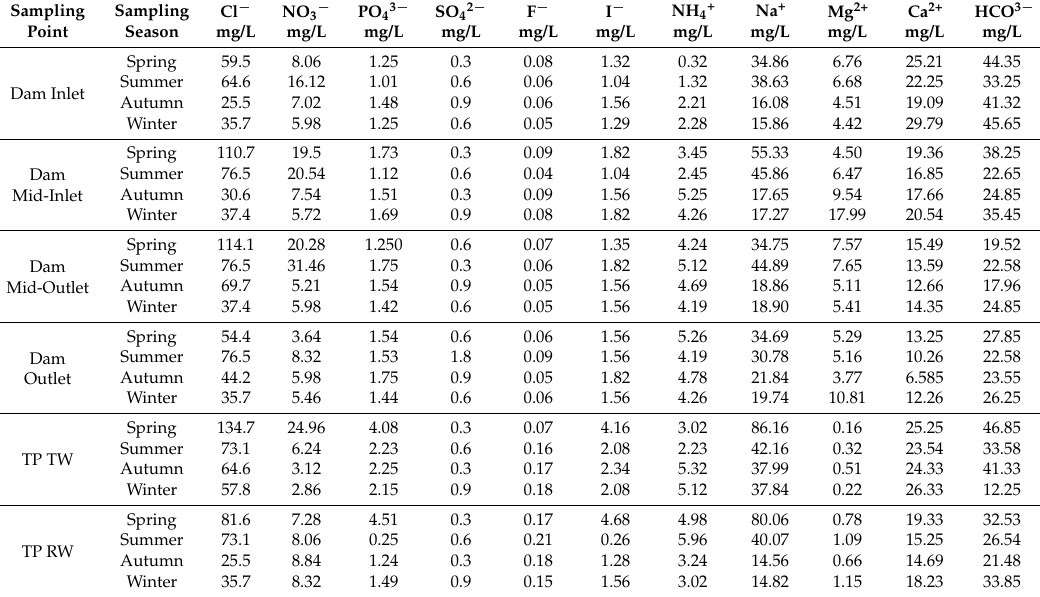
Table 5. The concentration of the mineral ions that contribute towards water salinity in the Nandoni Dam for the water samples collected in spring and summer 2016, and autumn and winter 2017. Sampling